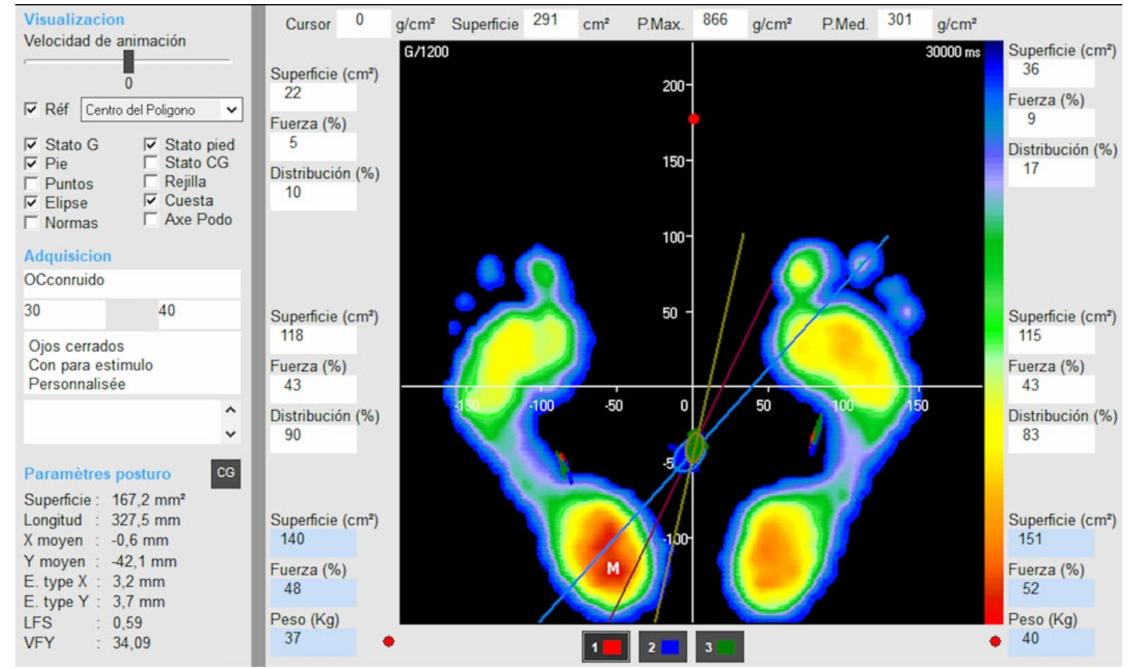
Figure 2. Software used for measuring dynamic balance